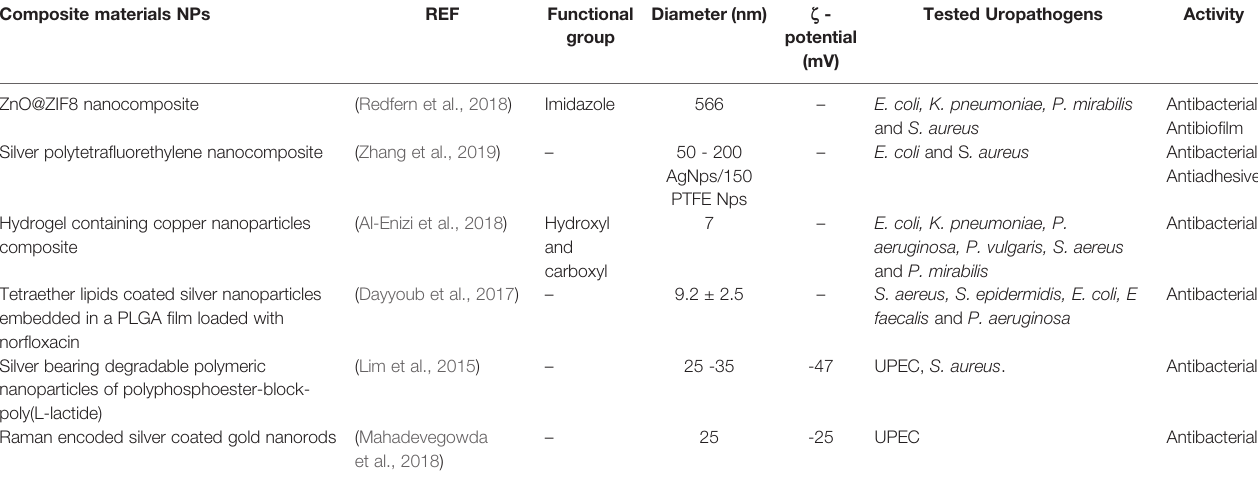
TABLE 11 | Physicochemical characteristics of composite materials-based